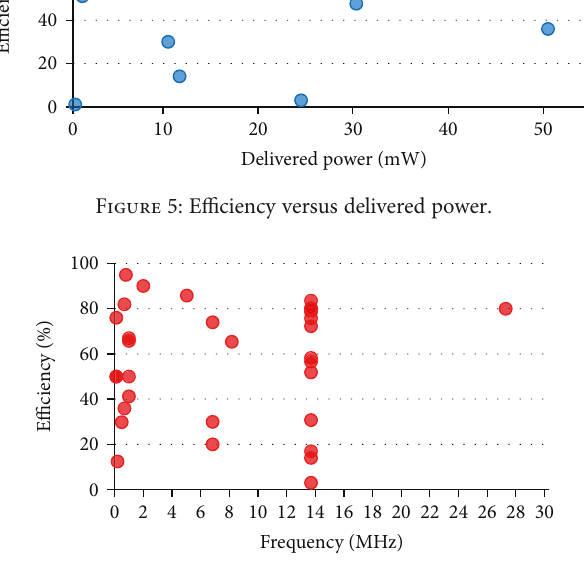
Figure 6: E ffi ciency versus